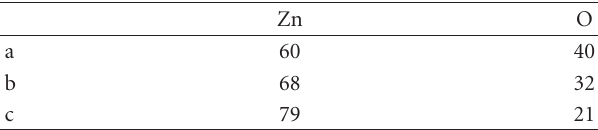
a ZnO electrode at the cathodic peak potential for 17 hrs.